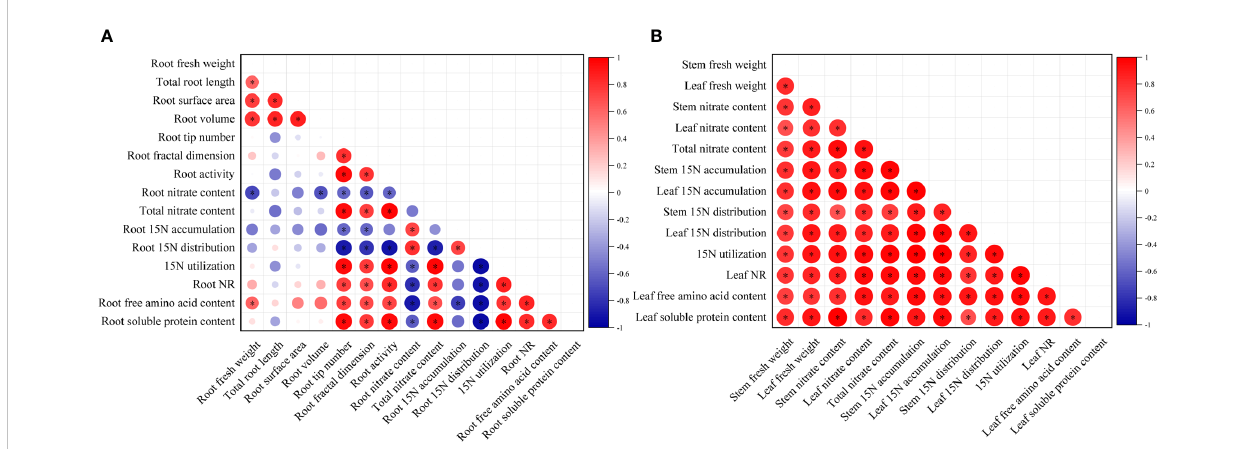
FIGURE 7 Correlation analysis of root growth indices (A) , and stem and leaf fresh weight (B) with nitrate metabolism parameters under MWCNTs treatment. Root growth indices indicate root fresh weight, root architecture parameters, and root activity; nitrate metabolism parameters indicate nitrate content, accumulation, and distribution ratio of 15 N-KNO 3 in each organ, 15 N-KNO 3 utilization ratio, NR activity, free amino acid, and soluble protein content. The red circles in each small square represent positive correlations, and the blue ones represent negative correlations, the depth of the color represents the degree of correlation between two indicators. *Indicate signi fi cant difference at P <